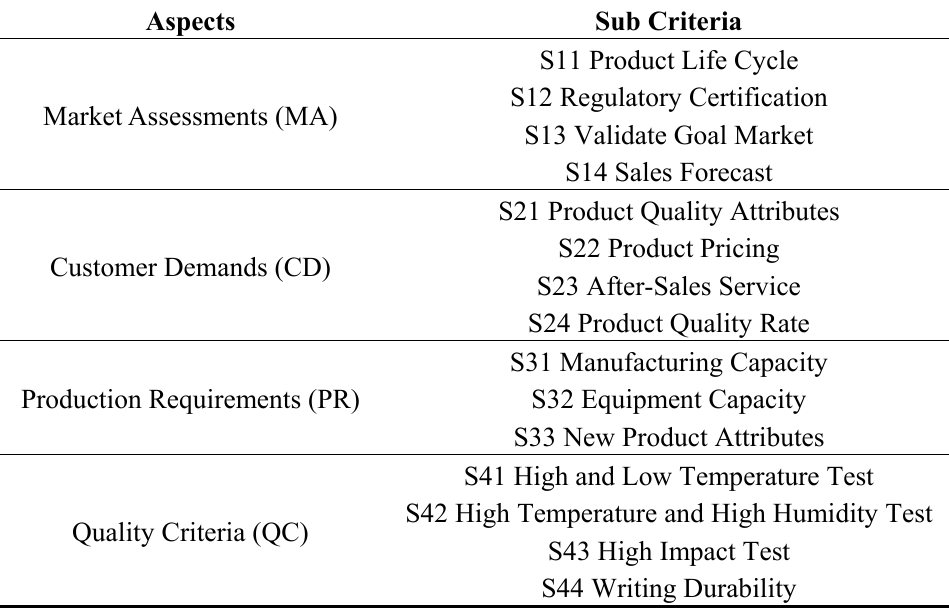
Table 1. Critical success factors for